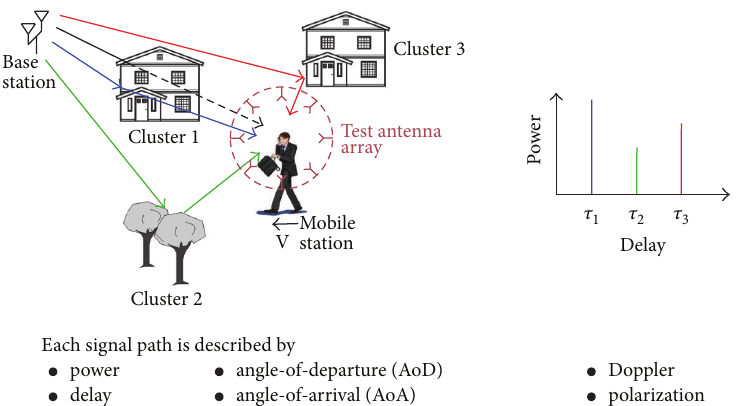
Figure 1: A typical multipath scenario and parameters to be considered in OTA emulation in a virtual electromagnetic environment (OTA in VEE).